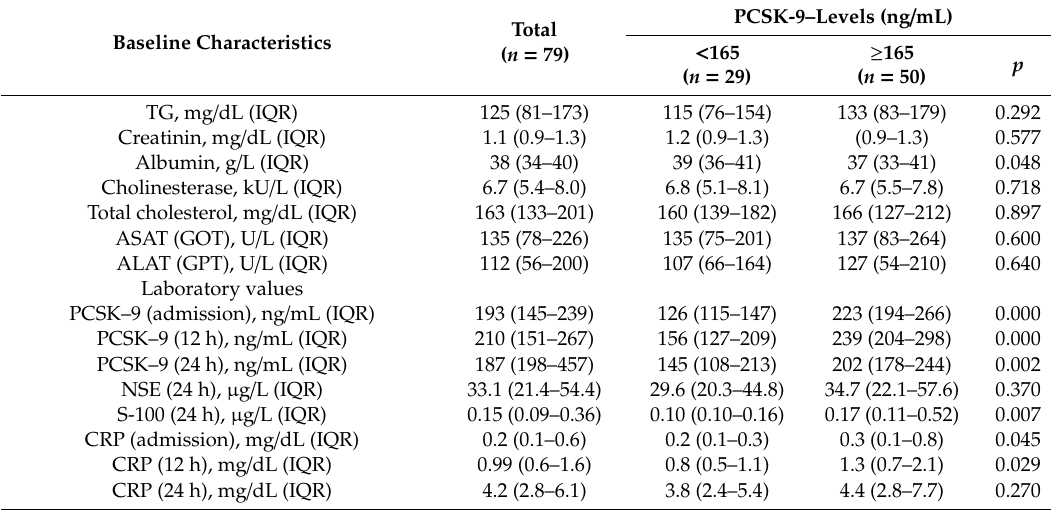
mortality was 180 ng / mL based on ROC analysis (AUC = 0.67, 95% CI 0.54–0.79, Figure 2) with a sensitivity of 81% and a specificity of